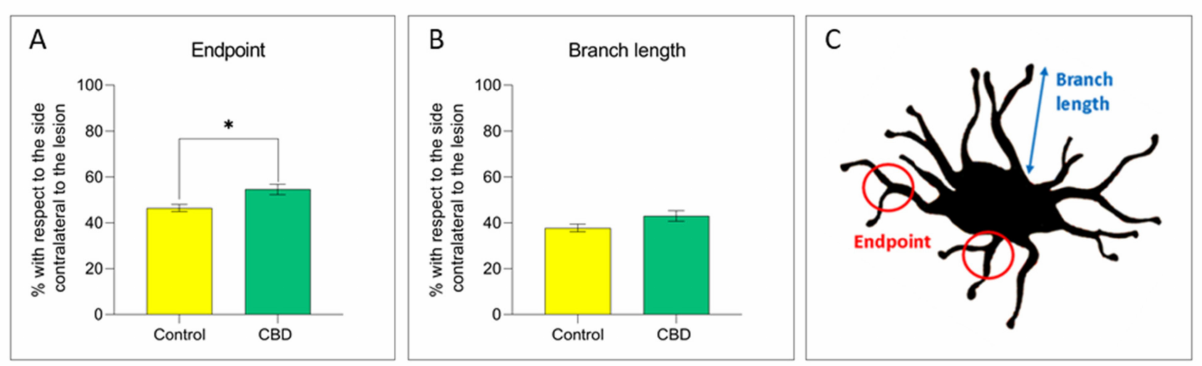
Figure 4. The graphs show the percentage of the ( A ) number of endpoints/cell and ( B ) branch length/cell ( µ m) in the SNc lesioned side with respect to the unlesioned side in both experimental groups. ( C ) Parameters analyzed to study microglial morphology. Results are expressed as mean ± SEM. * p < 0.05 vs. control t = 2992, df = 13, Student’s t -test unpaired two-tailed. N = 5 to 8 in each